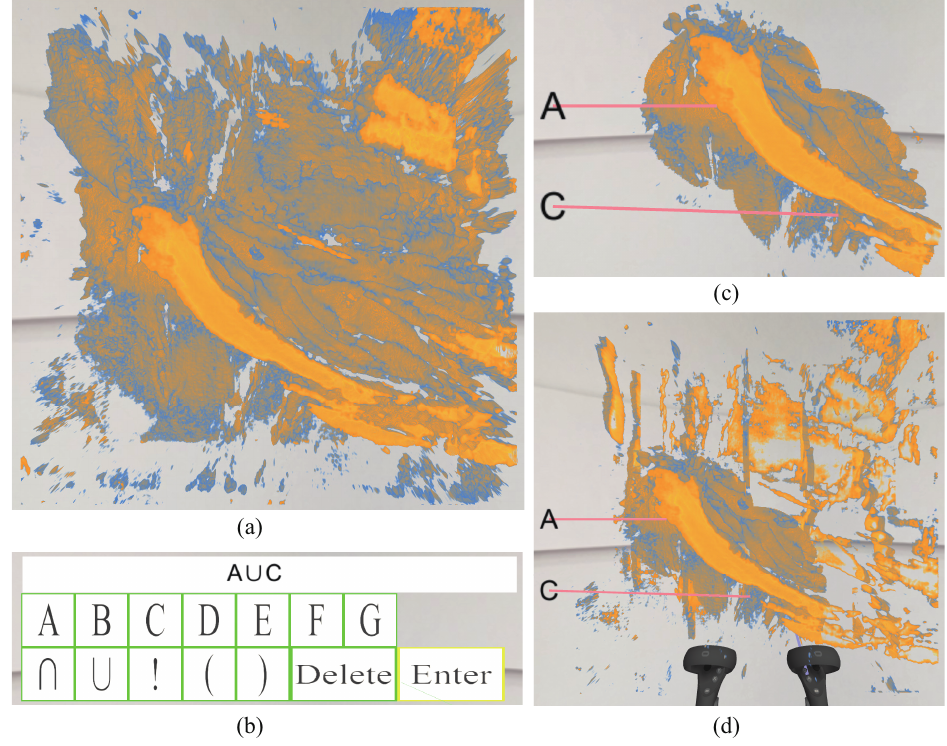
Figure 7. ( a ) The overall Dataset I is rendered on GPU by volume rendering. ( b ) The user inputs the set operation expression A ∪ C into the virtual keyboard. ( c ) The result of A ∪ C query in the Dataset I. ( d ) The combination of the cross-shaped display mode and the extracted stratigraphic